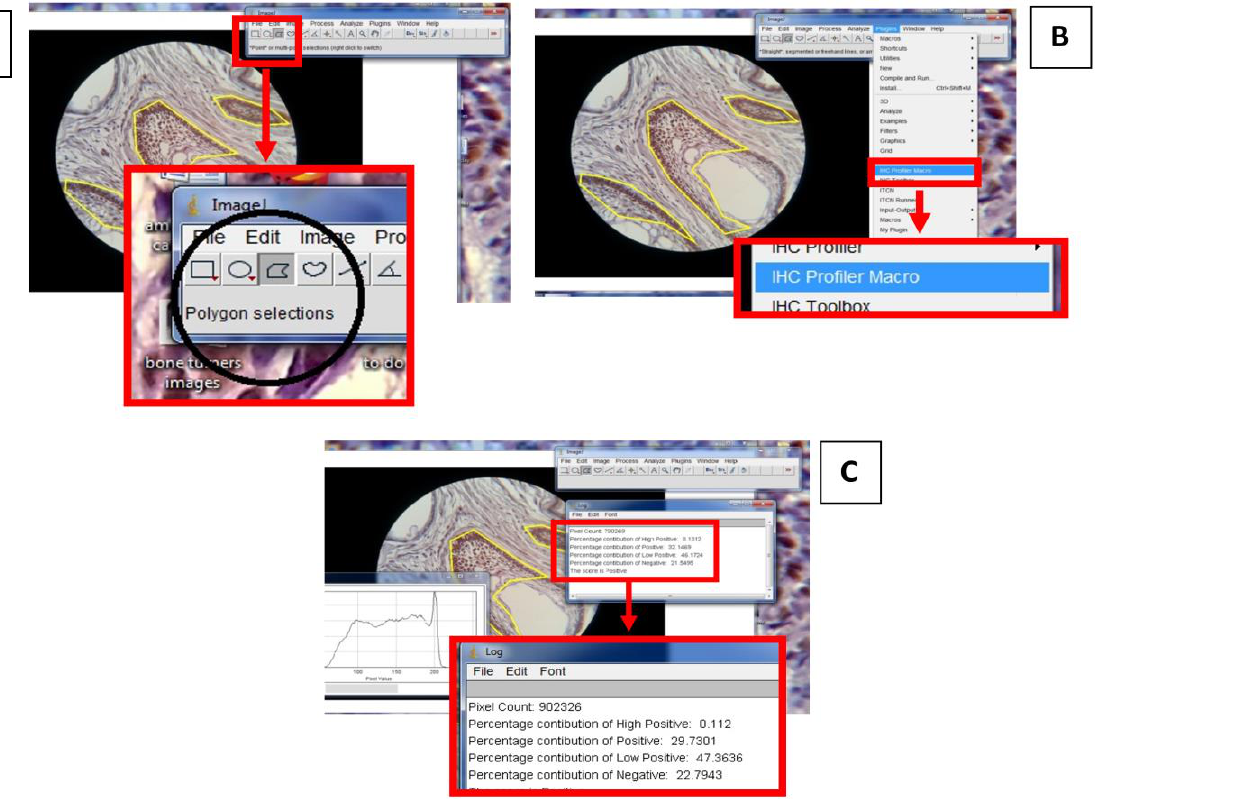
Figure 1: (A) Applying multiple polygon selection to regions of interest (ROI) of an image. (B) Choosing “IHC profiler macro” from the Imagej’s plugins drop down menu. (C) Software’s Results